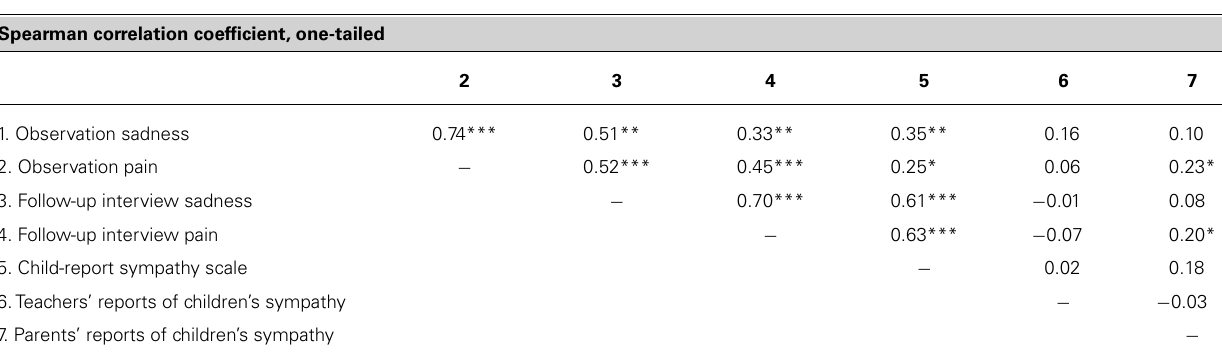
Table 3 | Intercorrelations of the methods measuring sympathyT2. Spearman correlation coefficient, one-tailed